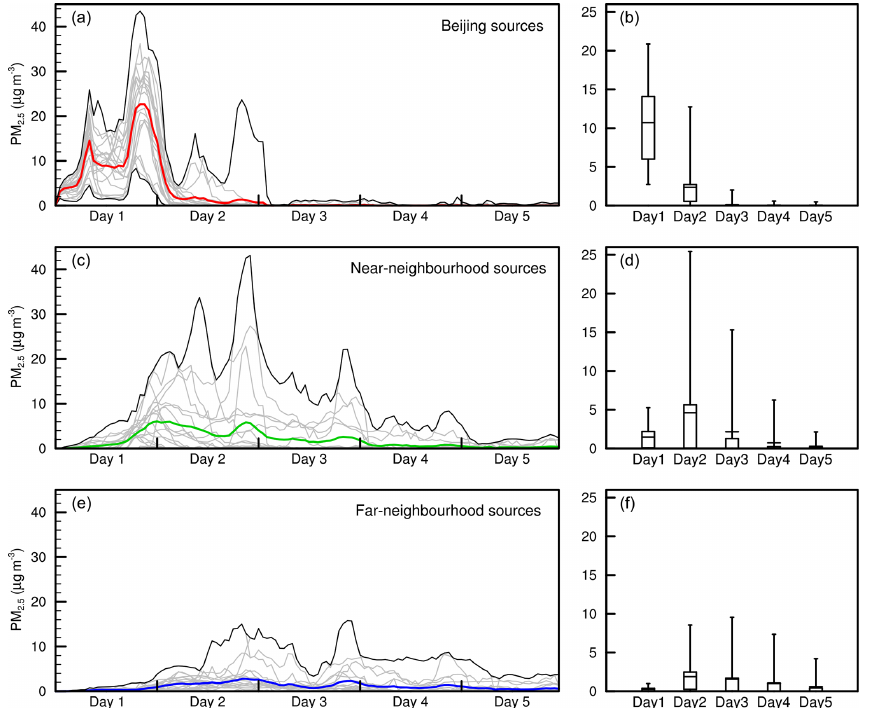
Figure 4. Time evolution of hourly (a, c, e) and daily (b, d, f) contributions to PM 2 . 5 concentrations in Beijing due to 1d emission changes in the Beijing (a, b) , near-neighbourhood (c, d) , and far-neighbourhood (e, f) source regions in October and November 2014. The contribution of individual days is shown in grey, mean contributions are coloured, and maximum and minimum contributions are shown in black. Boxplots (b, d, f) show the mean, 25th and 75th percentiles, and maximum and minimum contributions across all runs each day.